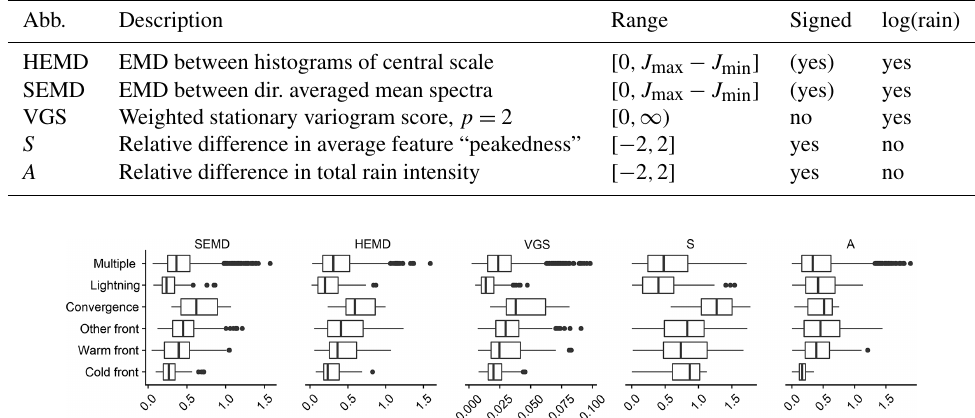
Figure 10. Distribution of absolute values for all scores (matching forecast and observation dates), separated by weather event.